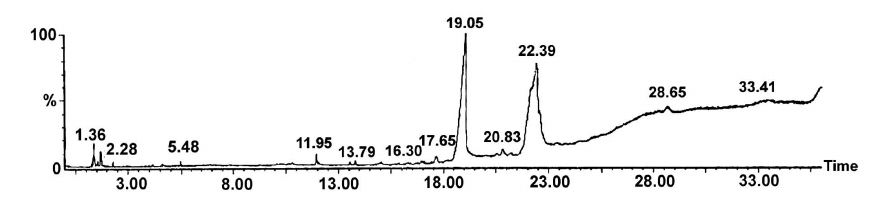
Fig . 3. – GC-MS chromatogram of the active fraction of Falkenbergia- phase of A. Table 3. – Compounds identified from the active fraction of Falkenbergia -phase of A. taxiformis using GC-MS. Sl. No